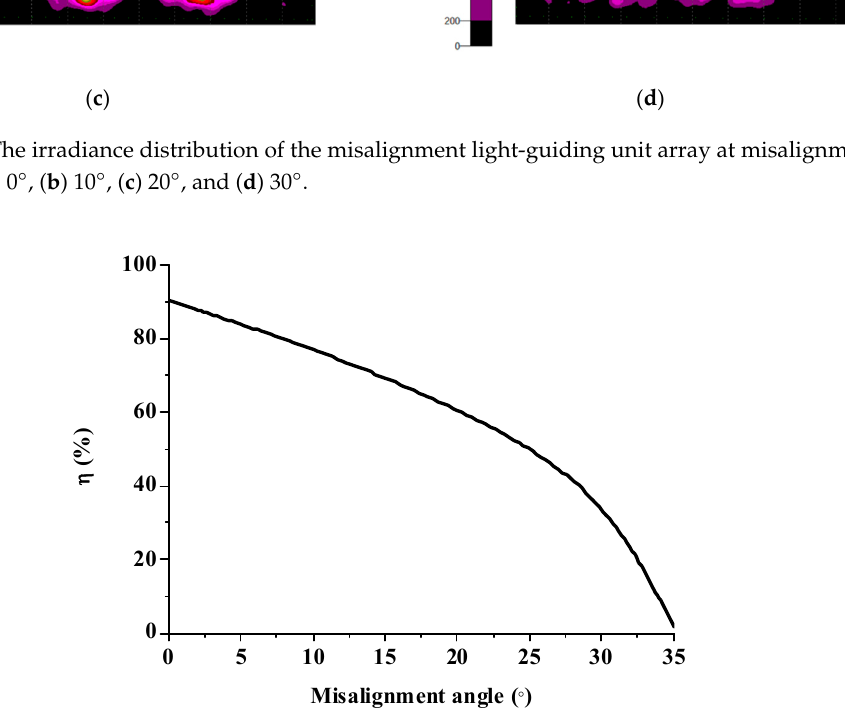
Figure 26. The optical e ffi ciency of the misalignment light-guiding unit Figure 27. The optical efficiency of the misalignment light-guiding unit array.